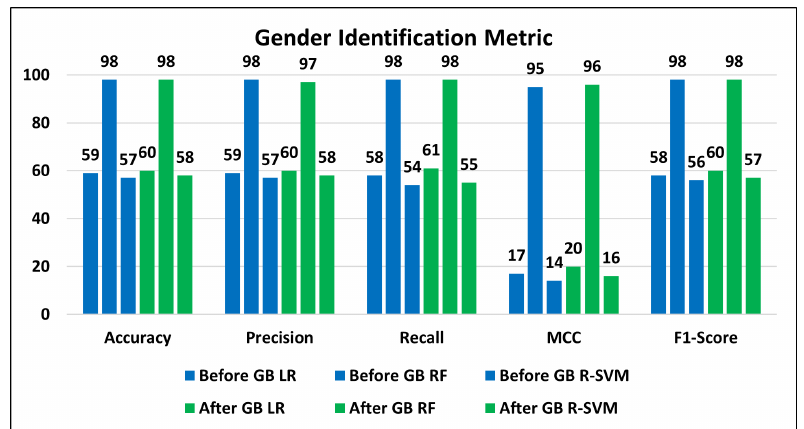
Figure 11. GB improved performance metrics of LR, RF, and R-SVM.